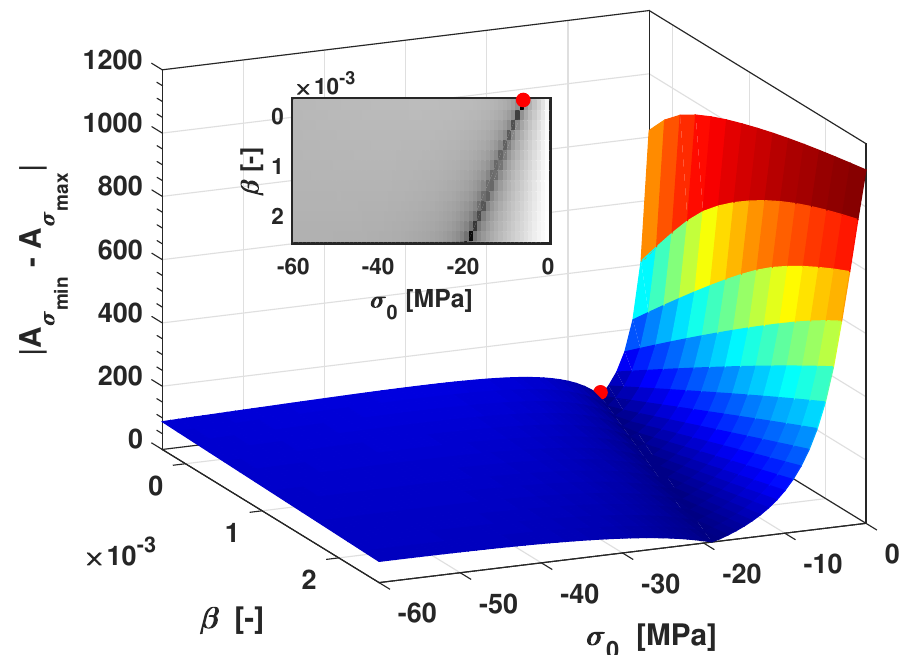
− A σ | surface of Equation (13) with respect to β and σ Figure 5. | A σ max min shows the top-view of the surface with a gray logarithmic color-map scale, while the red dot indicates the